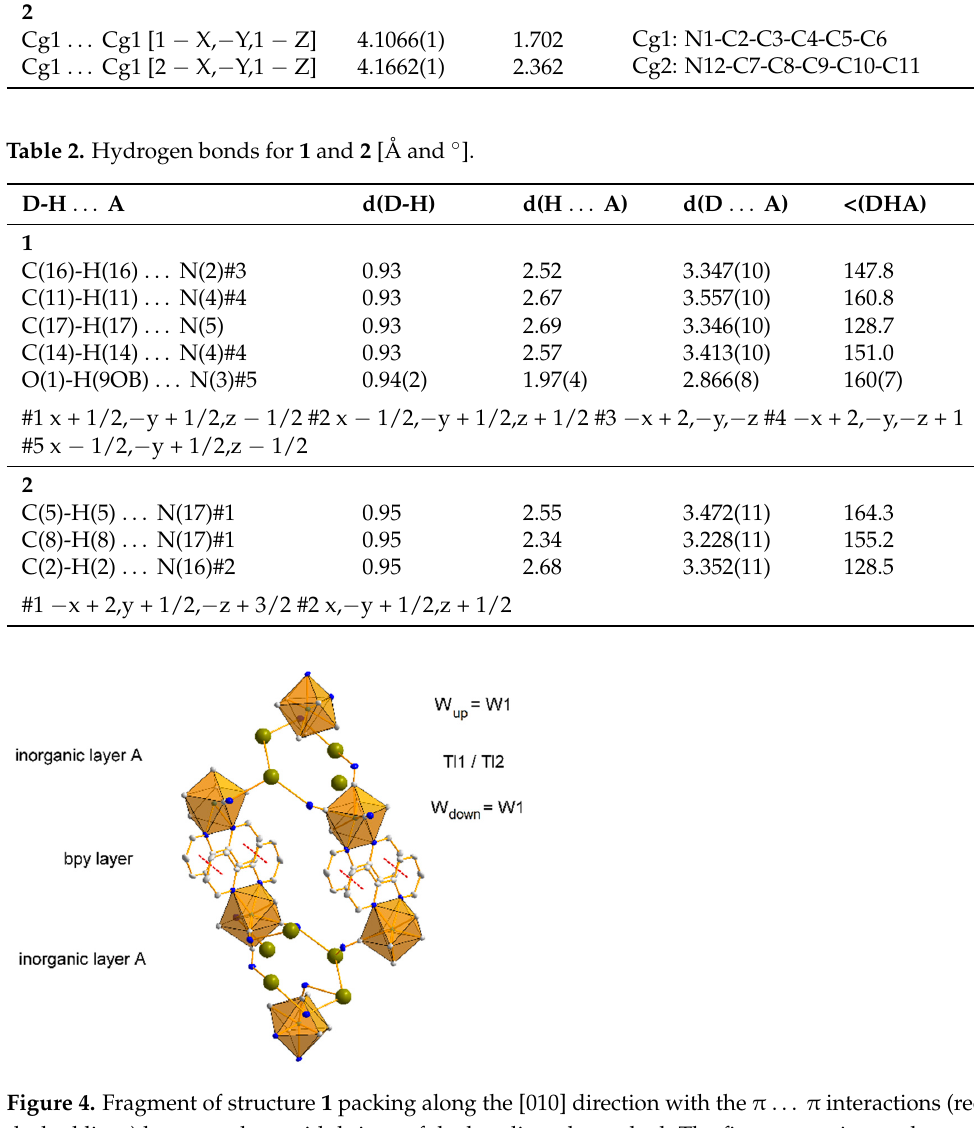
Figure 5. The geometry of the coordination environment of the thallium cation in compound 2 , along with the metallic environment. W-Tl distances in angstroms are given in parentheses. The “side-on” type bridging interactions are marked in green, and the “end-on” type in red. “Side-on” interactions between cyanides ( π electrons of the cyanide group) and alkali metal ions were observed previously by Rauchfuss et al. in caged cyanometalanes [40– 42]. Similar interactions were also described in the work of Gokel et al., except that the “side-on” interactions involved alkene/alkene units and alkali metal cations [43–46]. In addition, in our earlier work on monocationic systems (K + , Rb + , Cs + ) with [W(CN) 6 (bpy)] 2 − / − , “side-on” cyanide interactions were described, which were obviously different from the cyanide interactions described here [23,26]. Identical coordination modes were observed for analogous potassium structures for both W(IV) and W(V) analogues, although in this case their ratio was reversed [22–28]. Interestingly, the coordination number of the thallium cation is 5 and is identical to the W(IV) analogue 1 . It was completely different for the potassium structures, because in the W(IV) analogue the coordination of the potassium cation was higher, and in the case of K1 it was 8 and even 11 if K-C and K-N are treated as separate bonds. In the same struc- ture, the other potassium cation K2 showed a coordination of 6 [26]. In the potassium